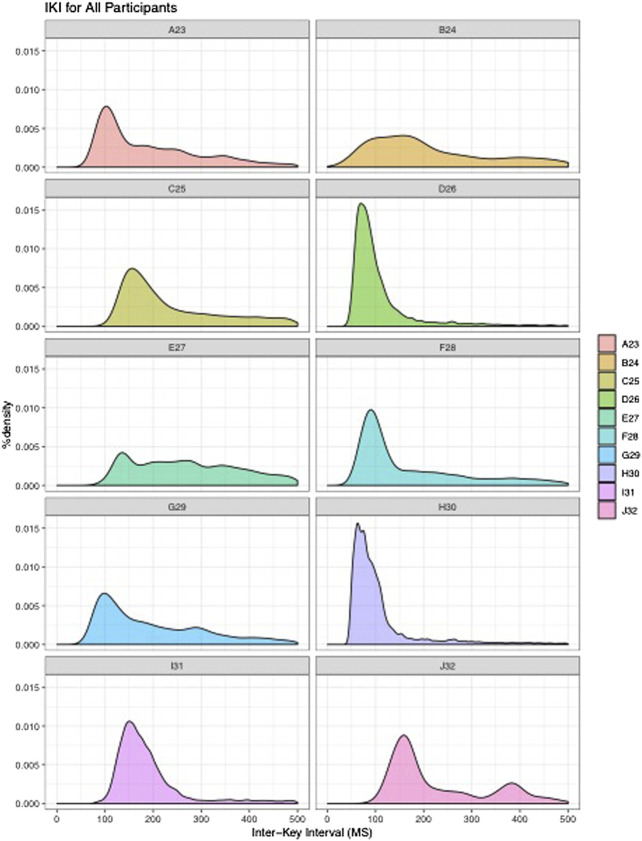
Density plots showing IKI for all participants.